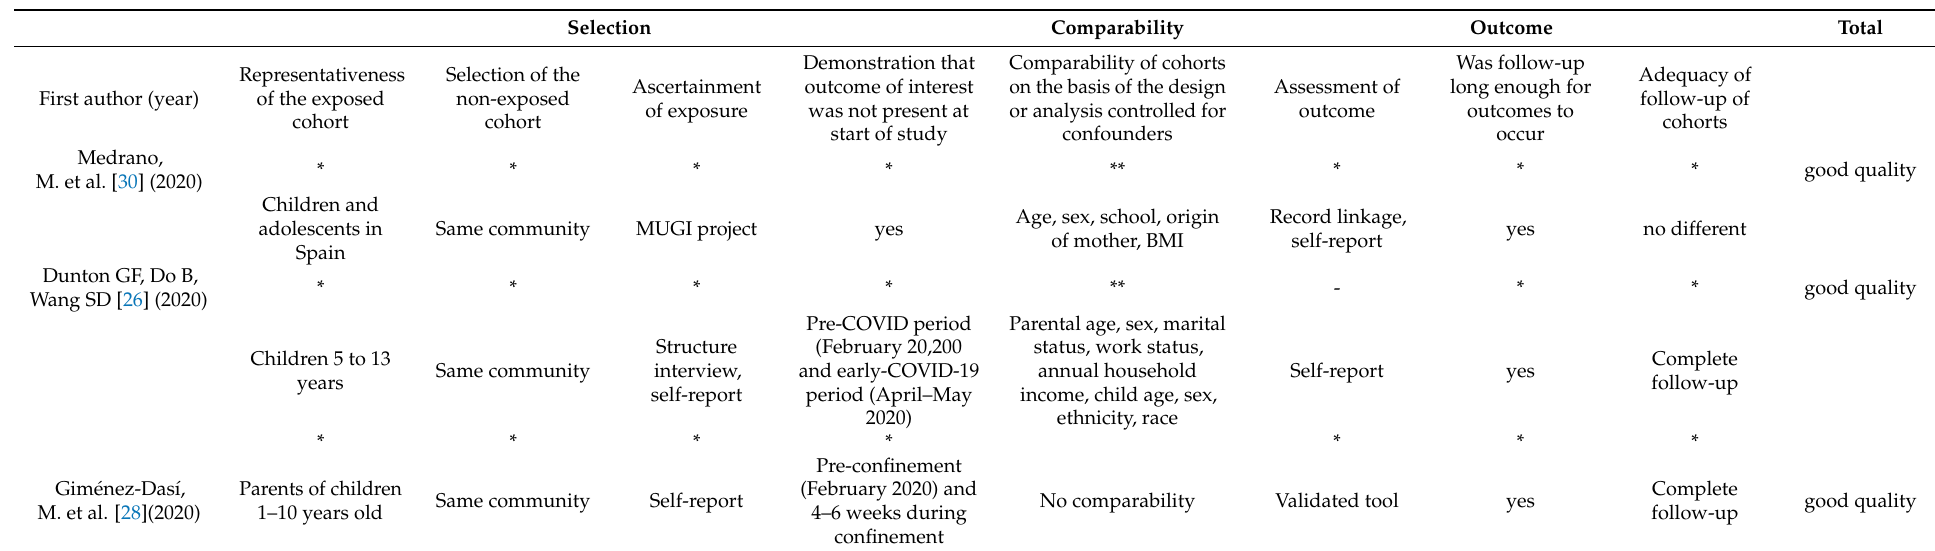
Table A2. Newcastle–Ottawa for Cohort